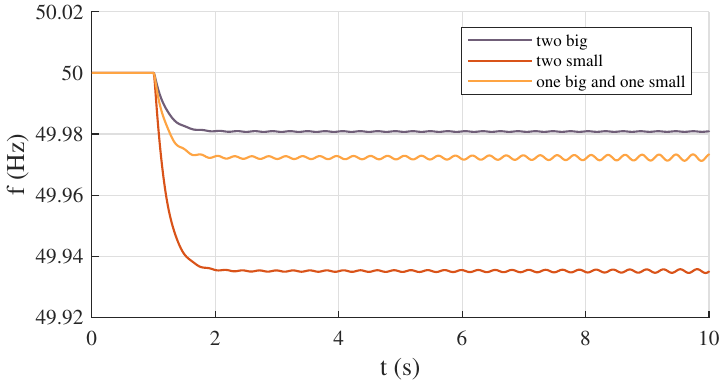
Figure 8. Impact of size of grid-forming